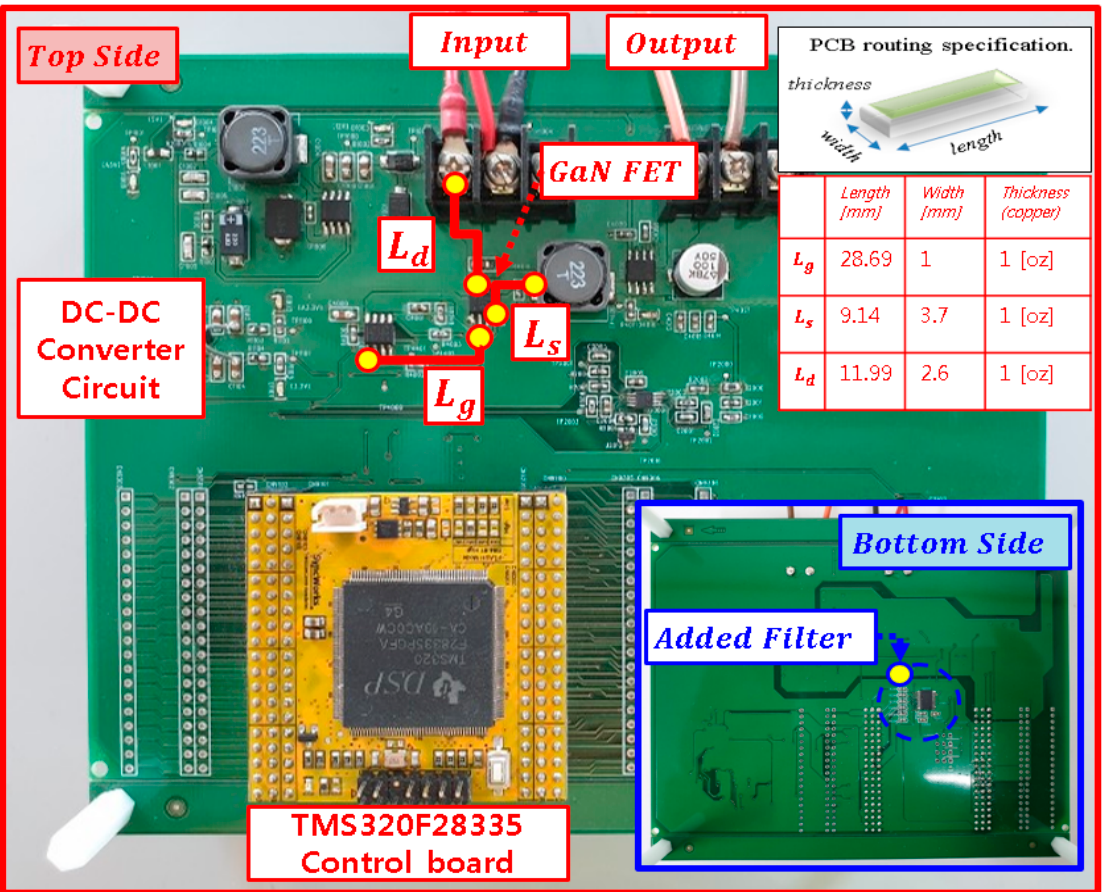
Figure 13. The stray inductance path in the self-manufactured PCB.